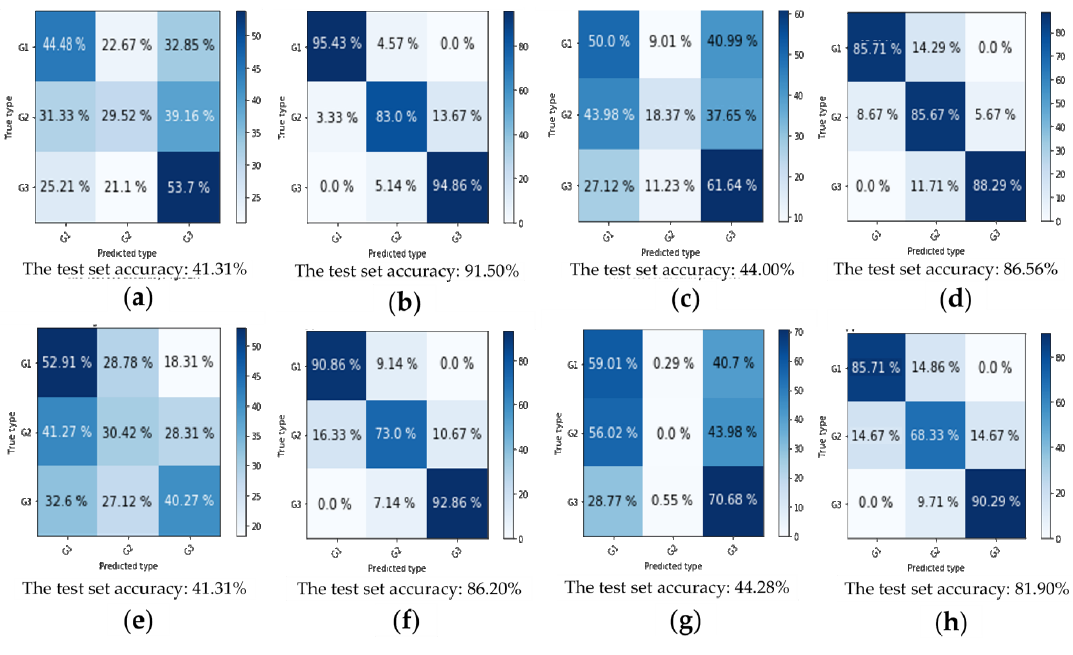
Figure 15. The effect of the data normalization and the elimination of outliers on the performance of models. ( a ) RF without DNEO, ( b ) RF with DNEO, ( c ) LDA without DNEO, ( d ) LDA with DNEO, ( e ) KNN without DNEO, ( f ) KNN with DNEO, ( g ) SVM without DNEO, ( h ) SVM with DNEO.